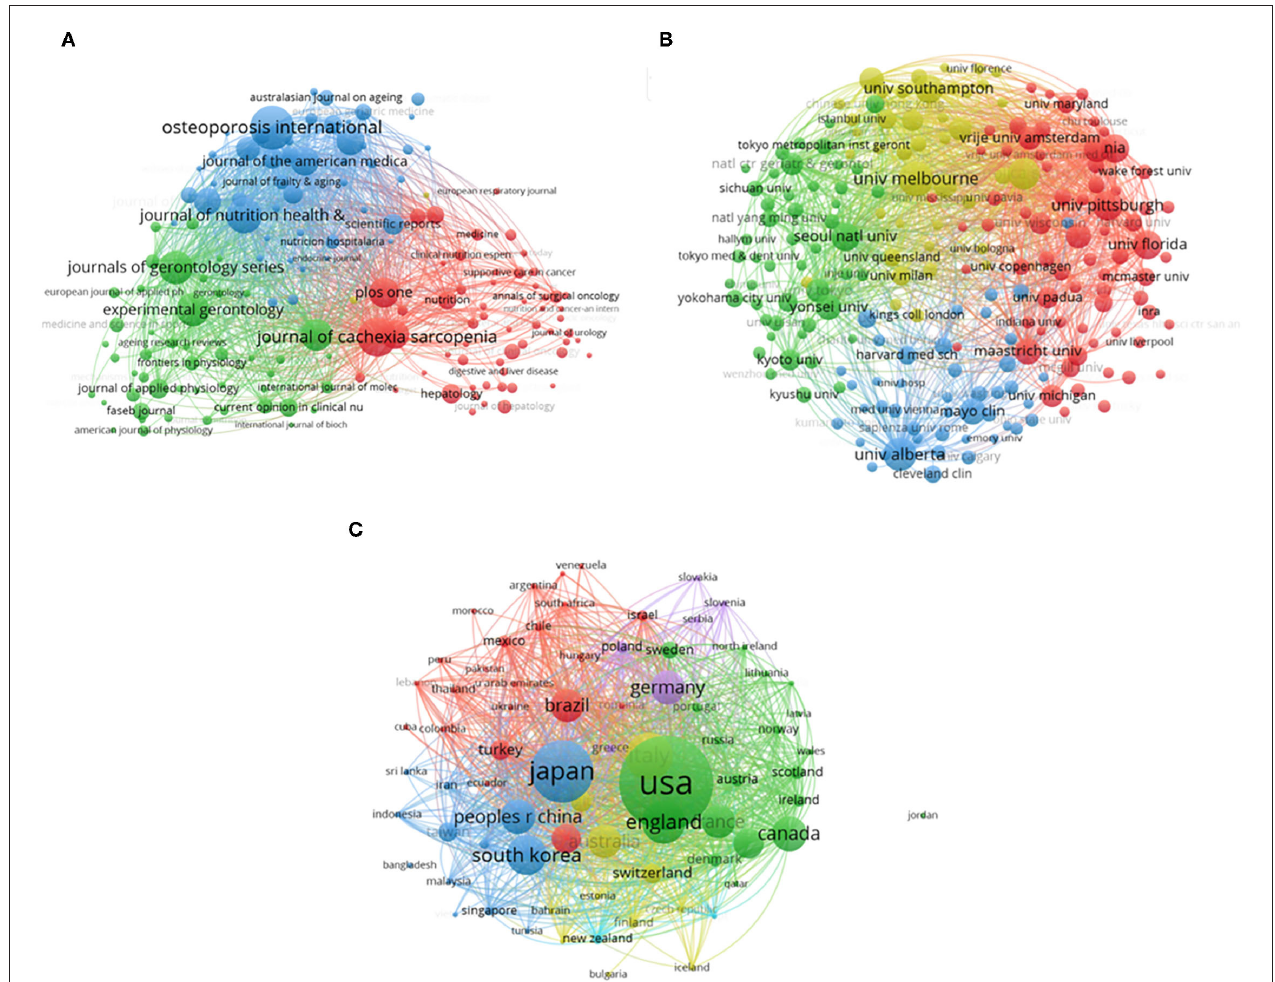
FIGURE 5 | Bibliographic coupling analysis of global research about sarcopenia. (A) Mapping of the 156 identified journals on sarcopenia. (B) Mapping of the 203 institutions on sarcopenia. (C) Mapping of the 74 countries on sarcopenia. The line between two points in the figure represents that two journals/institutions/countries had established a similar relationship. The thicker the line is, the closer the link between the two journals/ institutions/countries is.